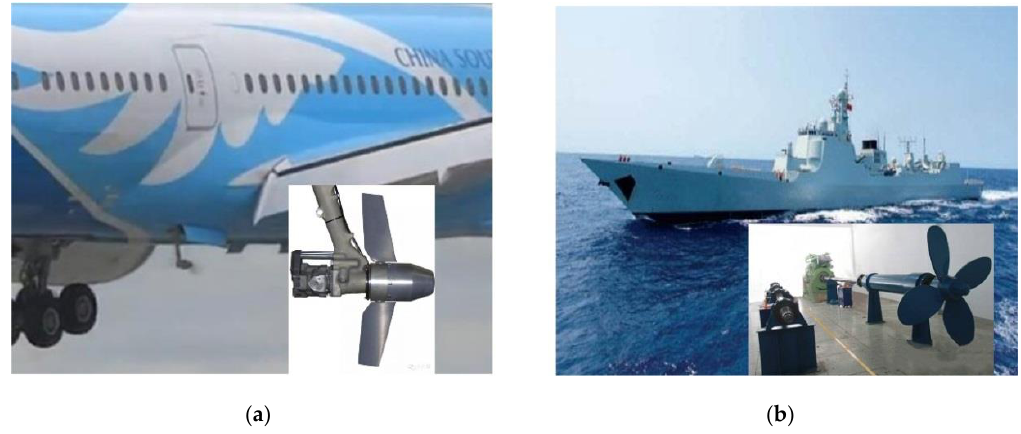
Figure 1. The industry application of gear coupling-rotor system (GCRS). ( a ) Application in the ram air turbine of aerospace. ( b ) Application in the propulsion shaft system.